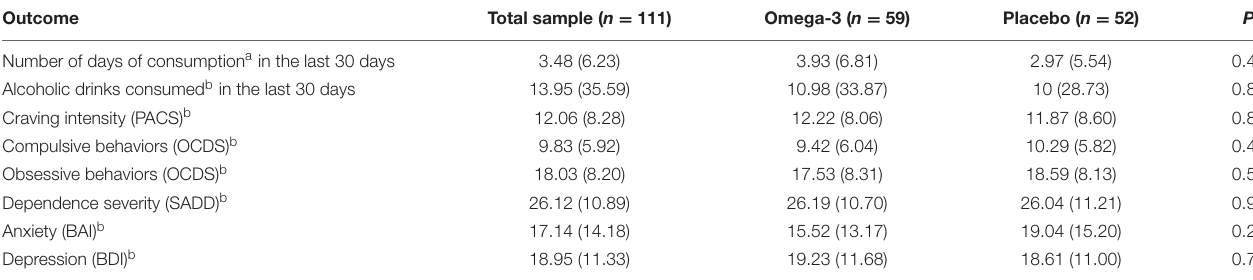
TABLE 2 | Mean ± (SD) for the outcomes related to substance use, craving, anxiety and depression at baseline (T0) for the total sample and by group. Outcome Total sample ( n = 111) Omega-3 ( n = 59) Placebo ( n = 52) P Number of days of consumption a in the last 30 days 3.48 (6.23) Alcoholic drinks consumed b in the last 30 days